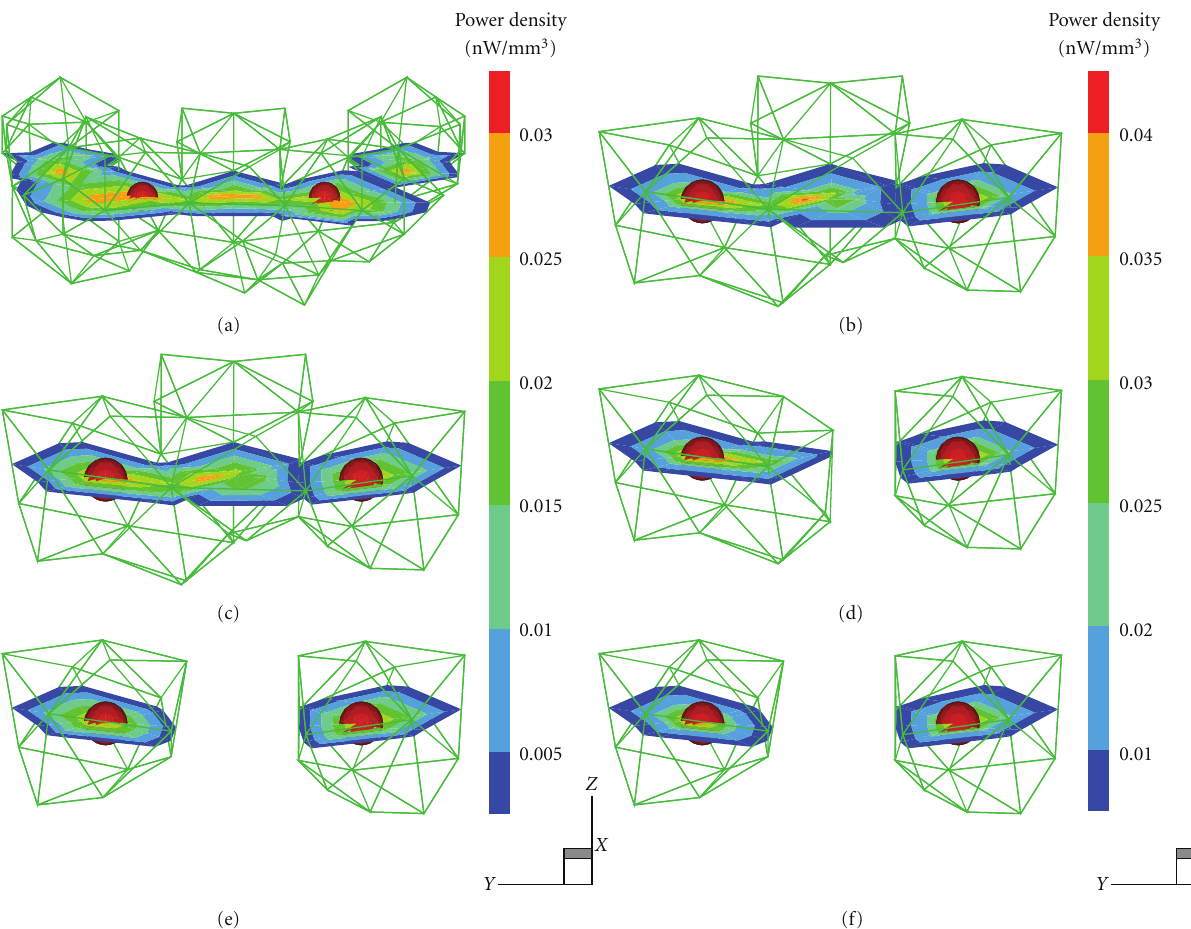
Figure 4: Top row: regularized solutions by Tikhonov regularization (left) and l 1– ls method (right). Middle row: corresponding final reconstruction results by GTS with a threshold of 0 . 35max( S i ). Bottom row: final reconstruction results by Tikhonov + MSDS (left) and l 1– ls + MSDS